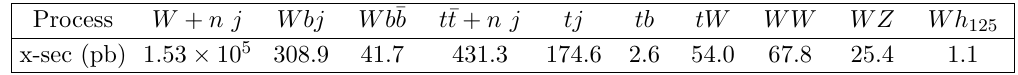
Table 2 . Parton-level cross sections of various background processes (without any cut) at the LHC ( p s = 13 TeV). Here, n is the number of